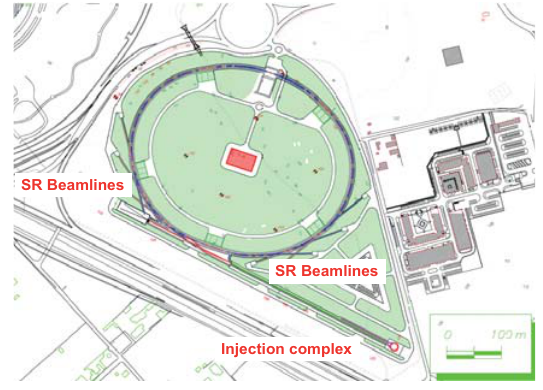
Figure 2. The SuperB accelerator complex